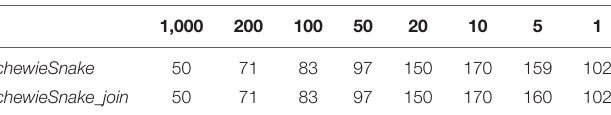
TABLE 3 | Cluster counts for chewieSnake and simulated chewieSnake_join